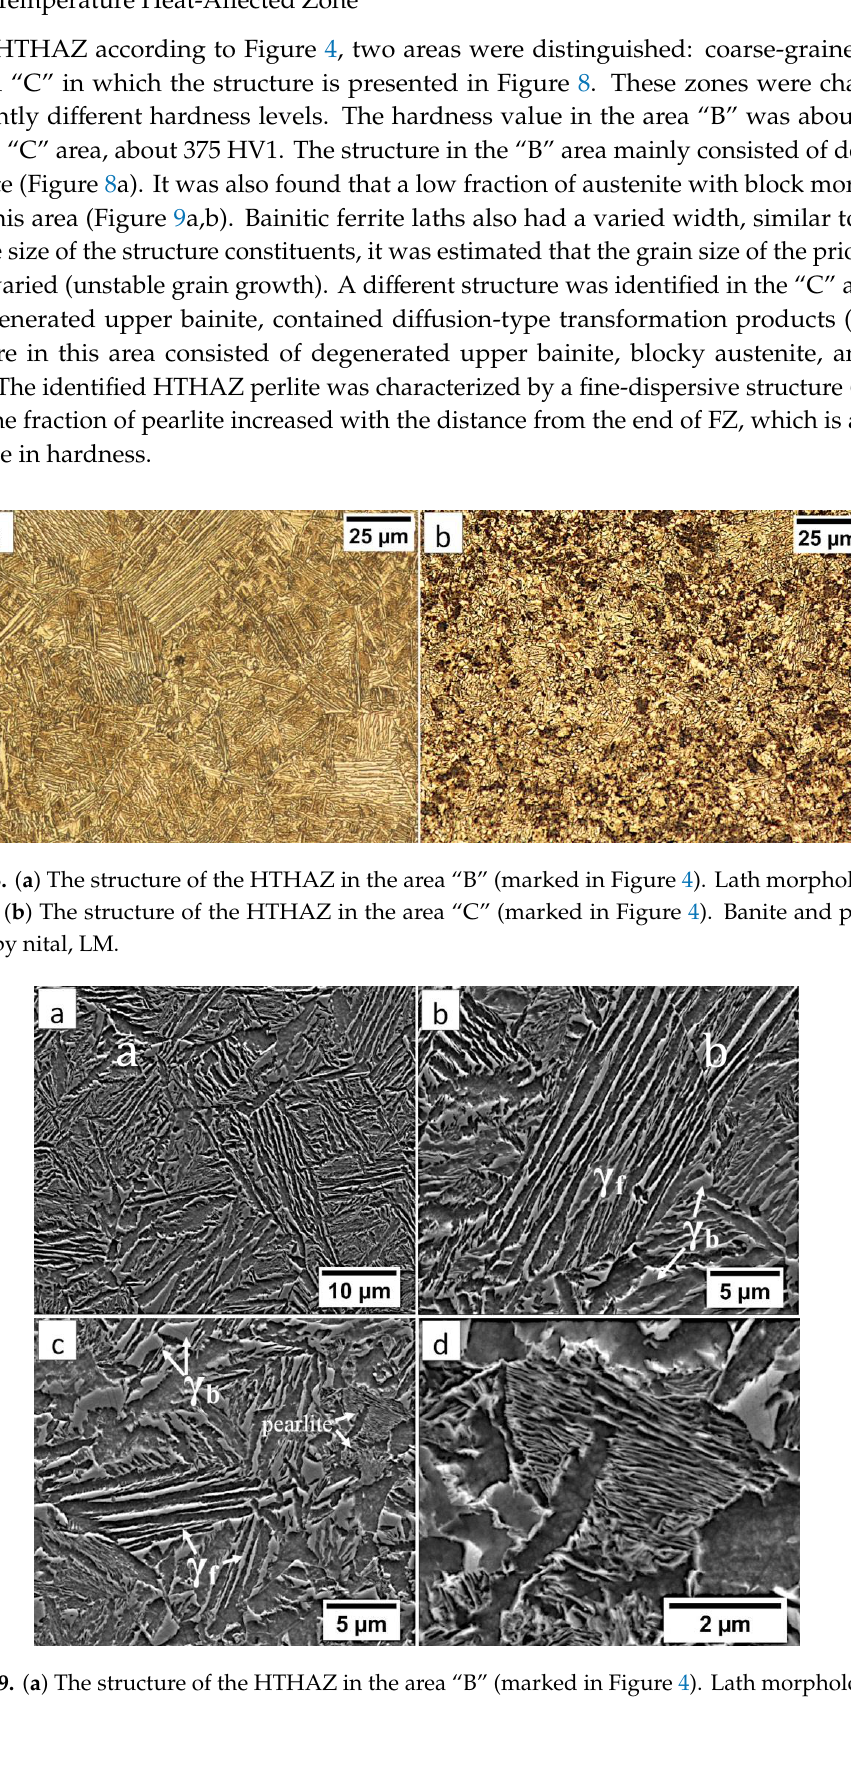
Figure 9. ( a ) The structure of the HTHAZ in the area “B” (marked in Figure 4). Lath morphology of bainite and blocky austenite. ( b ) The structure of the HTHAZ in the area “B” (marked in Figure 4). Different dimensions of bainitic ferrite laths and austenite with filmy (γ f ) and blocky (γ b ) morphology. ( c ) The structure of the HTHAZ in the area “C” (marked in Figure 4). Degenerated